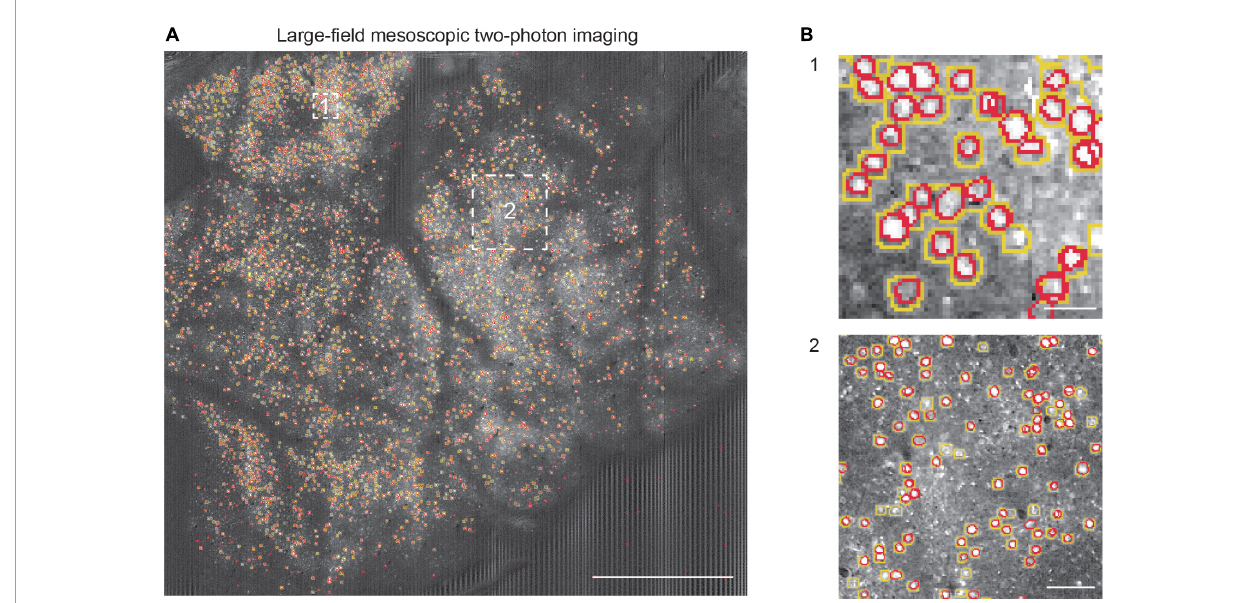
FIGURE7 Neuron segmentation in mesoscopic two-photon Ca 2 + imaging with NeuroSeg-II. (A) Segmentation results overlaid on the imaging data of GCaMP6s expressing neurons [mesoscopic data from the study of Sofroniew et al. (2016)]. The yellow outlines indicate the ground truth (GT) neurons, and the red outlines indicate the neurons segmented by NeuroSeg-II. Two regions are highlighted by the white squares and shown at an expanded spatial scale. Scale bar, 1 mm. (B) The effect of neuron segmentation at different scales. B1 scale bar, 20 µ m. B2 scale bar, 50 µ